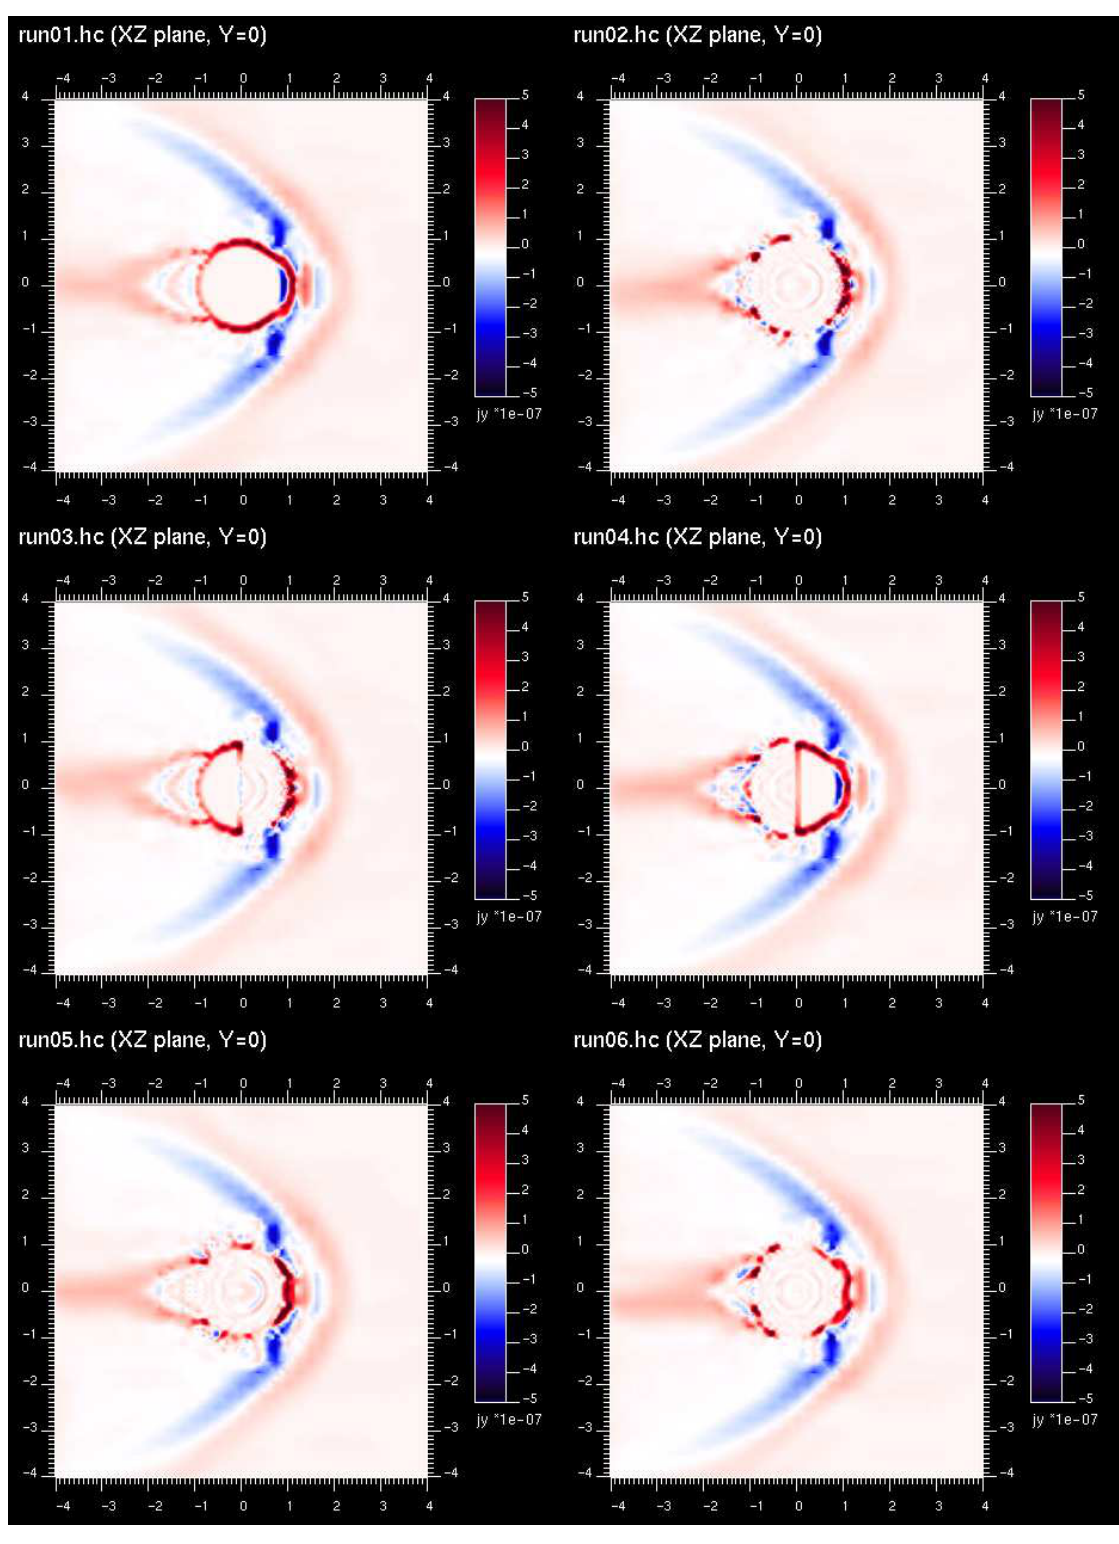
Fig. 4. The current density y component in the XZ plane in all runs (for definitions of runs 1–6, see Table 1). The horizontal axis is X (Sun is to the right) and vertical is Z (antiparallel to planetary dipole moment and parallel to IMF). The Y axis points toward the